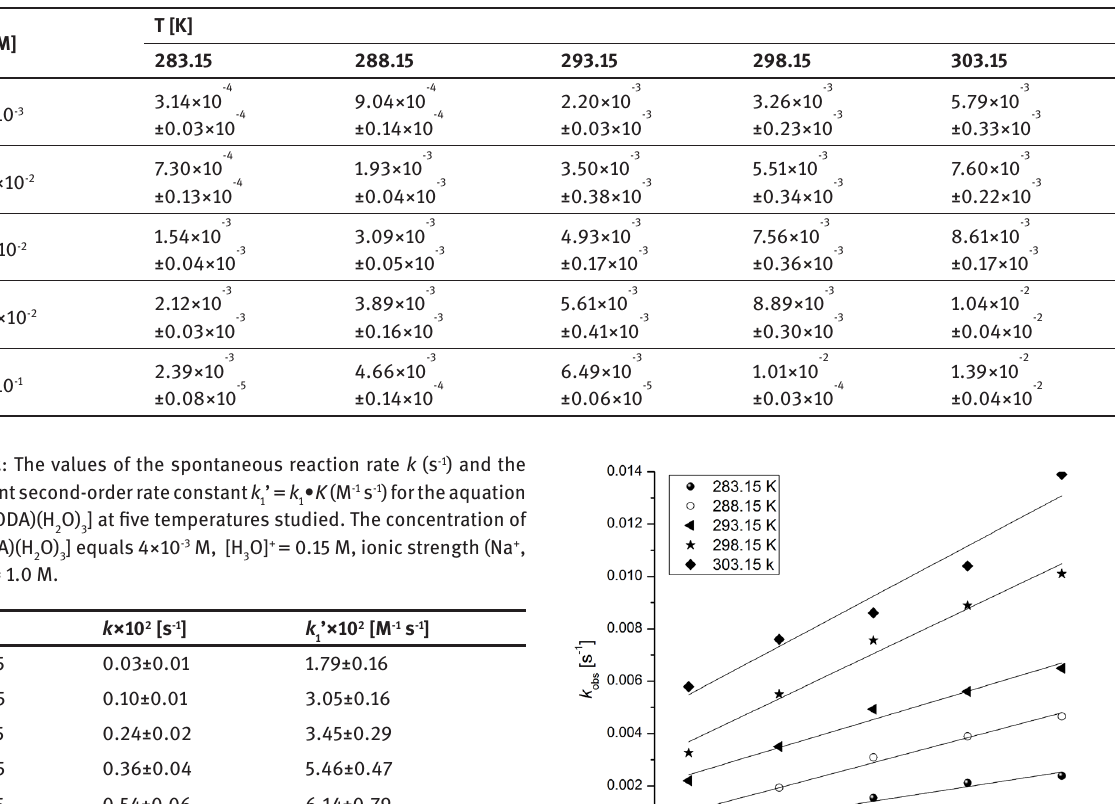
Table 1: The promoter concentration (in the 0.00125 M – 0.125 M range of the Fe(III) ions) dependence of the observed rate constants k of the aquation reaction studied at five temperatures. The concentration of [Co(ODA)(H I = 1.0 M. Standard deviation values are also given.